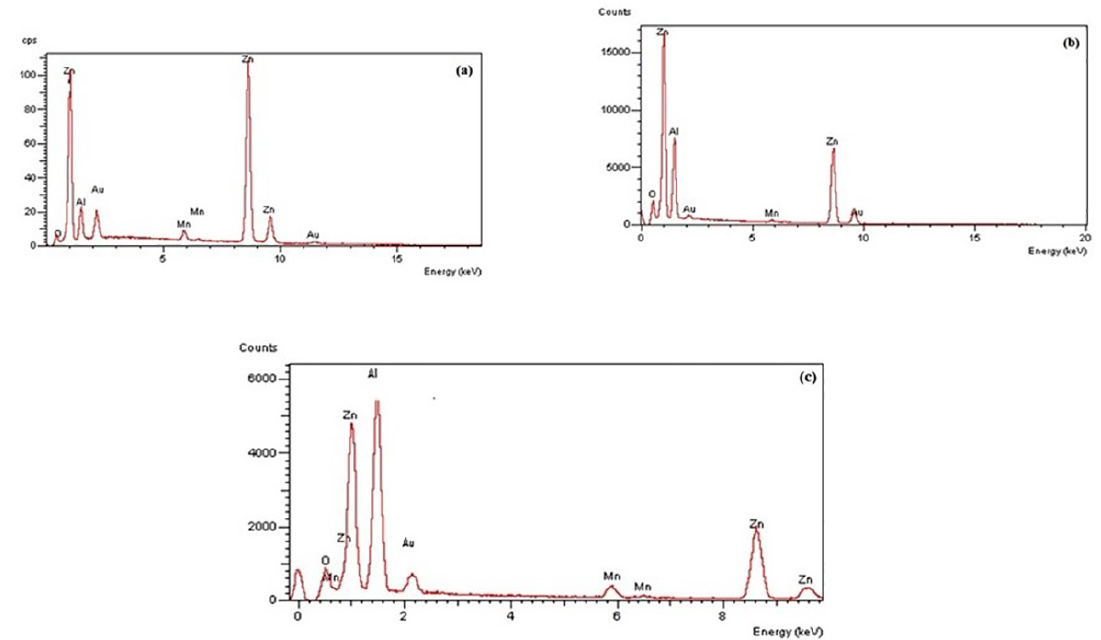
Figure 3: EDX image of the samples (a–c) calcined at 500°C for 1h on air.